Question: How would you classify this visualization?
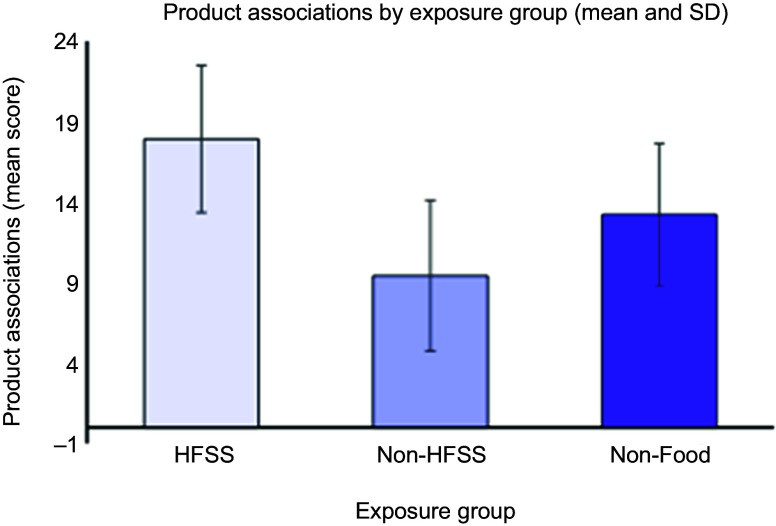
Answer: bar